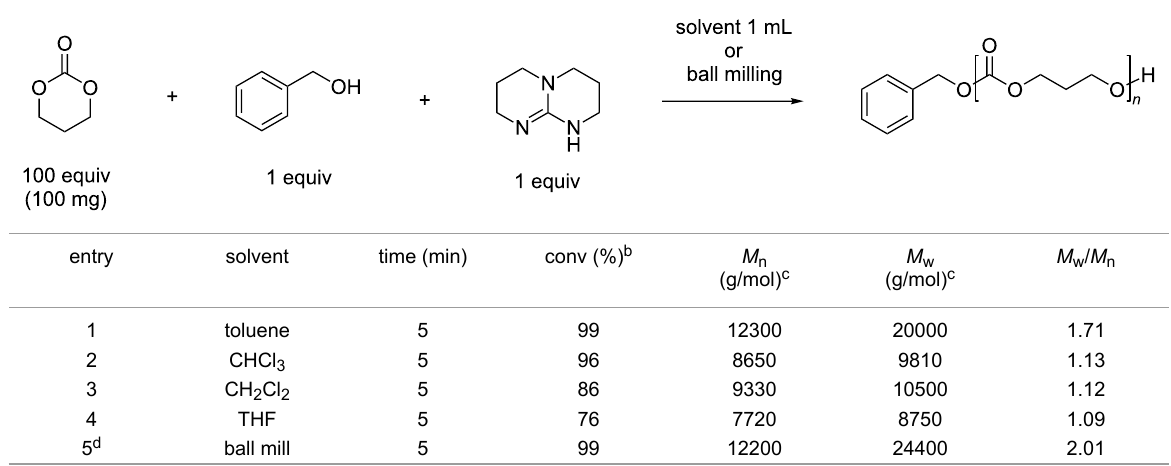
Table 4: TBD-catalyzed polymerization of trimethylene carbonate: solution vs ball milling.